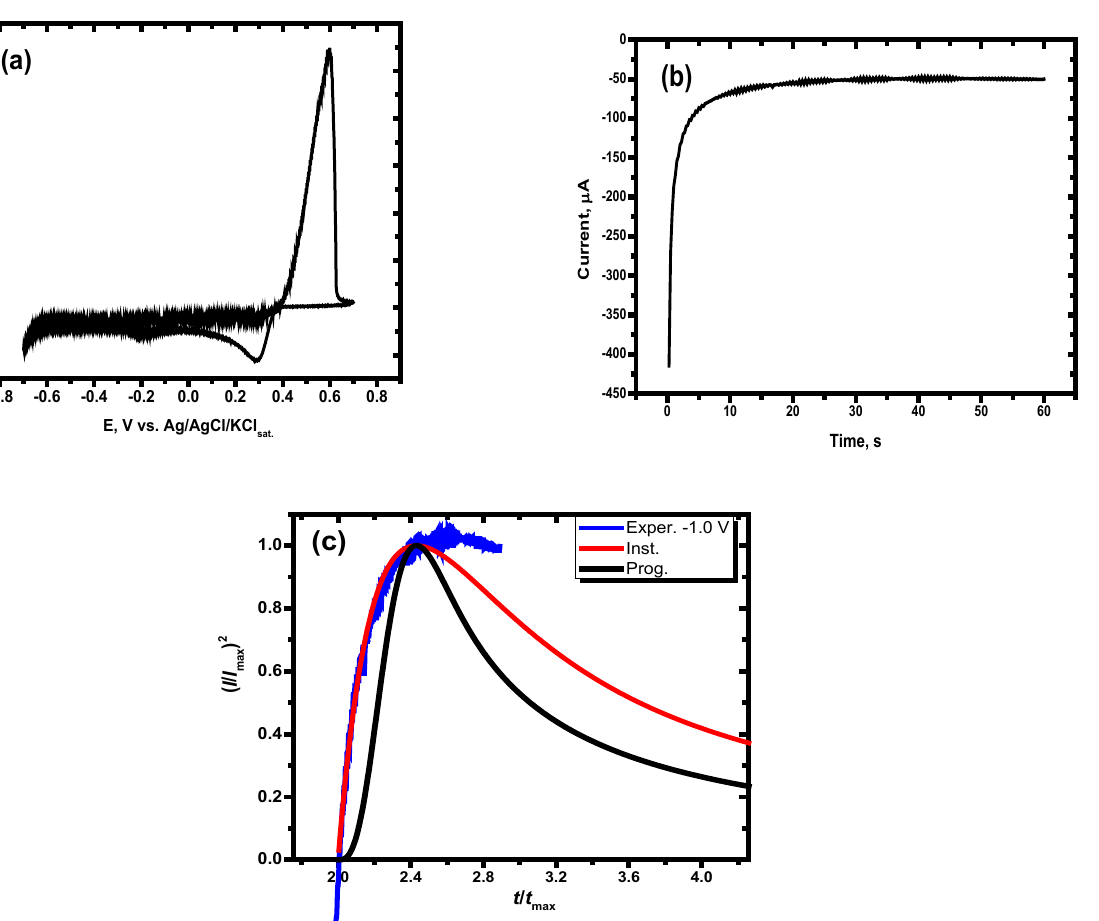
Figure 8. ( a ) Cyclic voltammetry of Ag, Pt, and Co ions as shown, ( b ) chronoamperometric behavior at E d = −0.60 V, and ( c ) ( I / I max ) 2 vs. ( t / t max ) relationship for experimental and theoretical data of the instantaneous and progressive crystal growth.